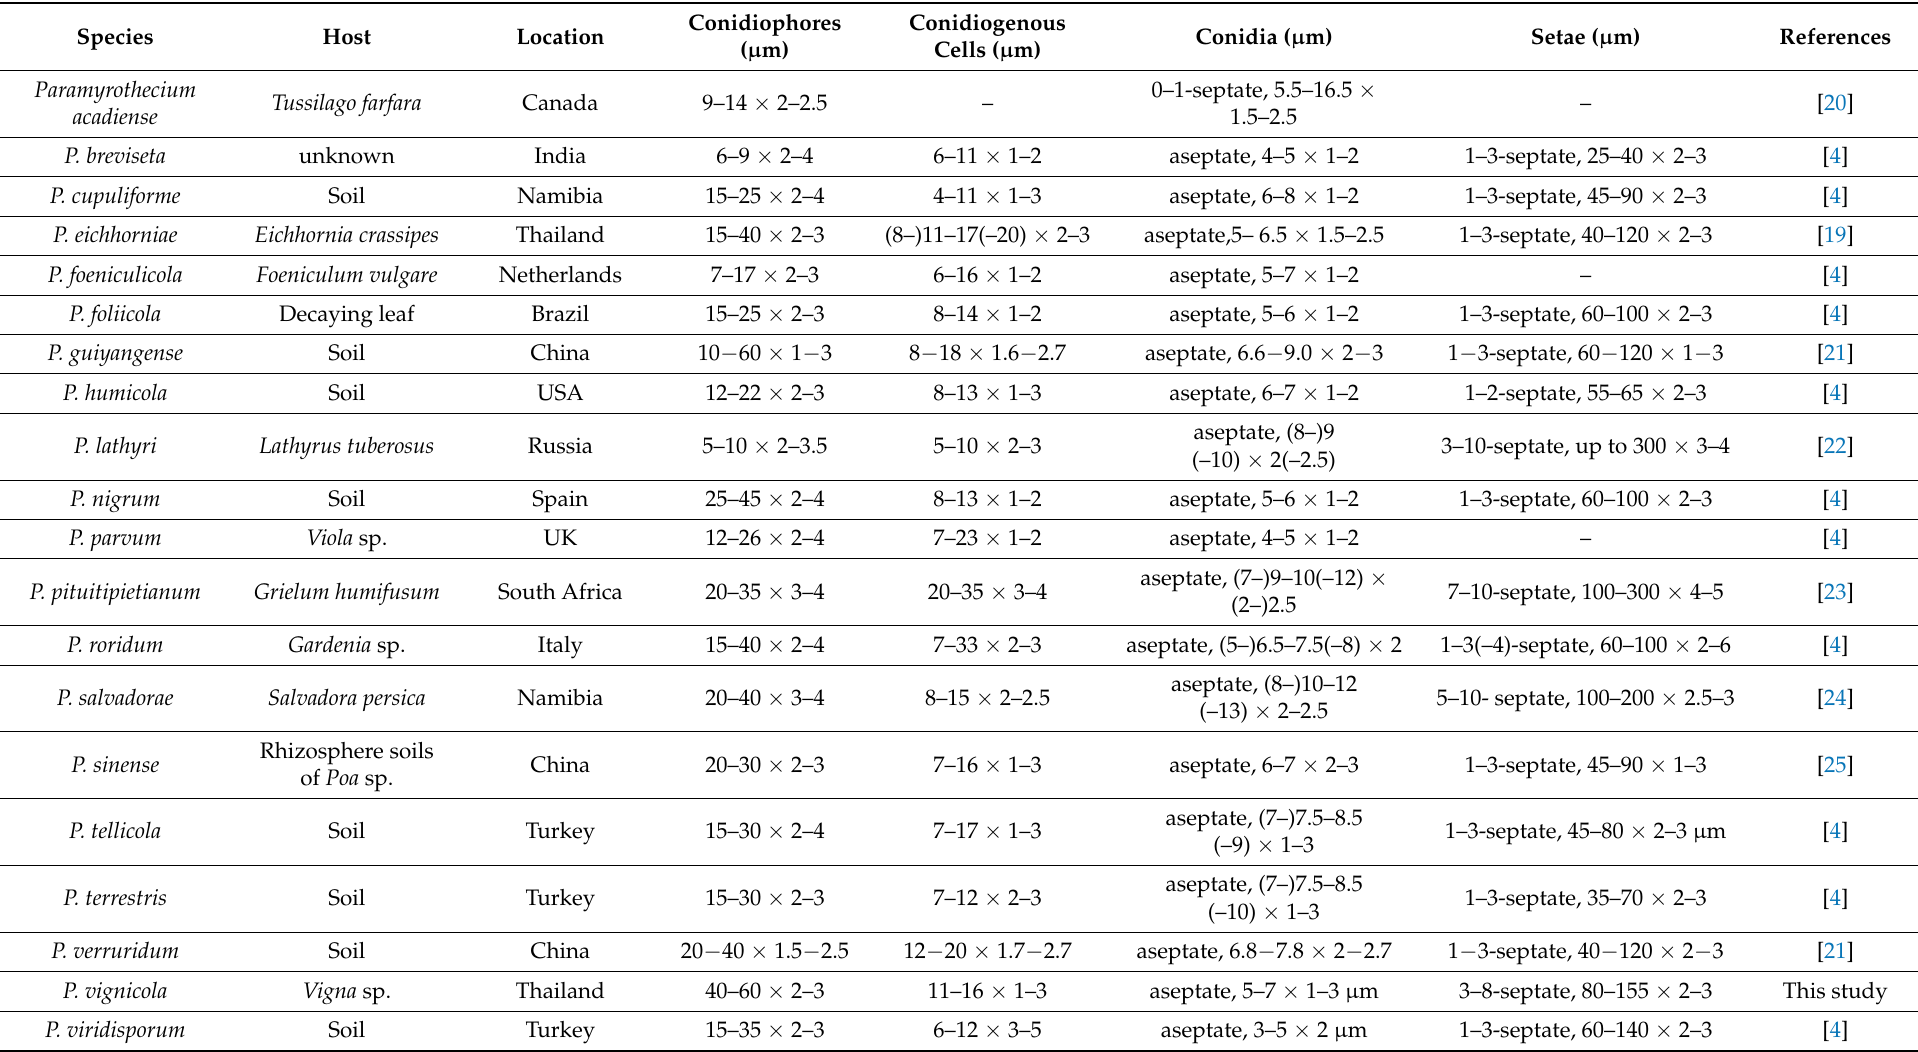
Table 1. Synopsis of Paramyrothecium type